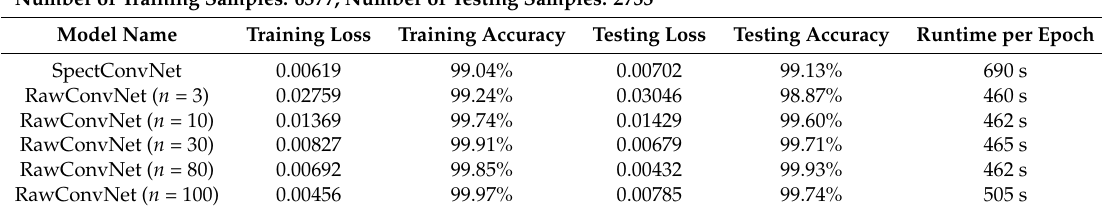
Table 3. SpectConvNet vs. RawConvNet on BUZZ1 train/test dataset with 70–30 train/test split. The parameter n denotes the size of the receptive field in the first layer of RawConvNet. Number of Training Samples: 6377; Number of Testing Samples: